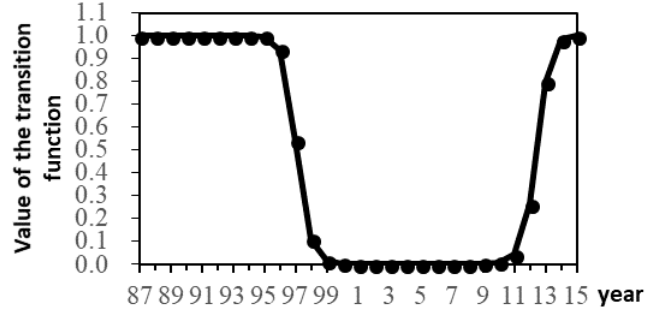
Figure 1. Changes of the transition function. Table 9. Comparison between linear model and nonlinear model.